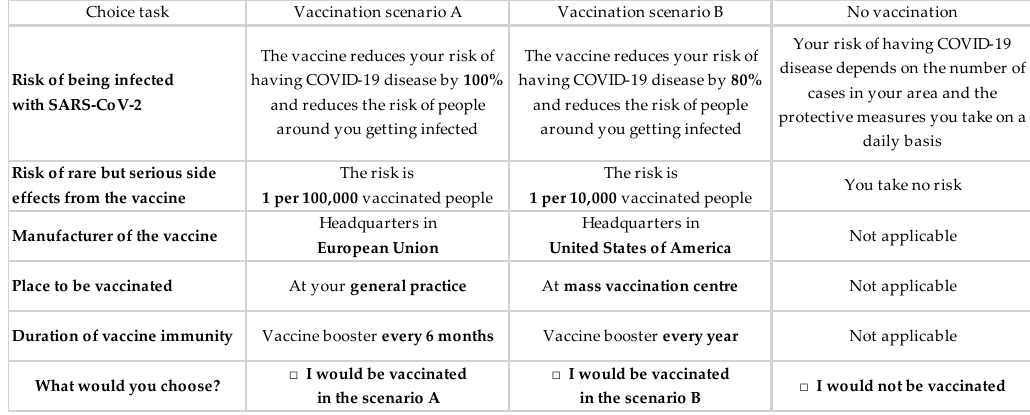
Figure 2. Choice task example in the discrete choice experiment used in December 2020.